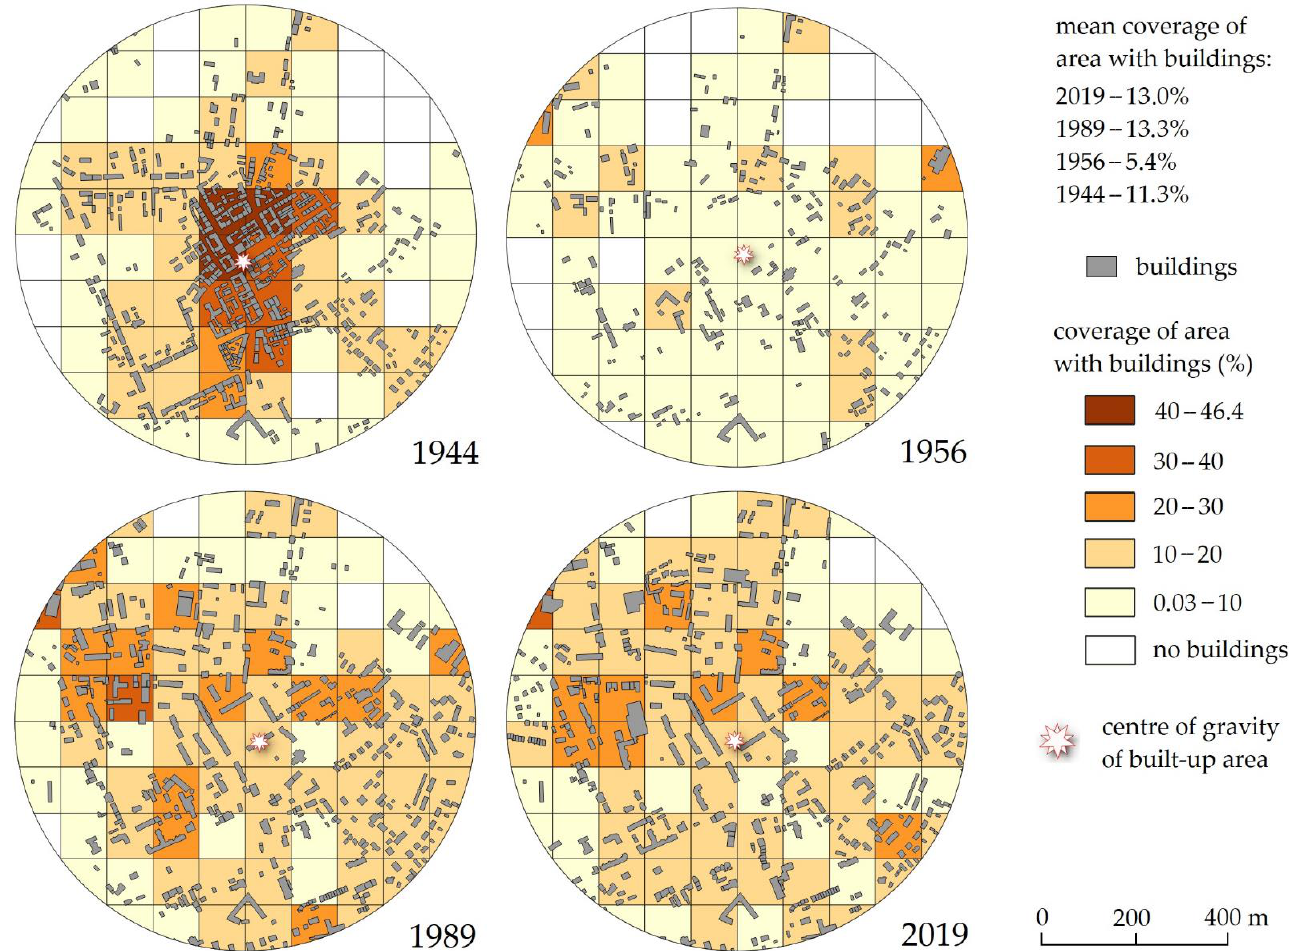
Figure 5. Changes in the development cover of the central area of Węgorzewo during the period 1944– 2019. Source: own studies based on archival and present plans for Węgorzewo [71,73,77,79].